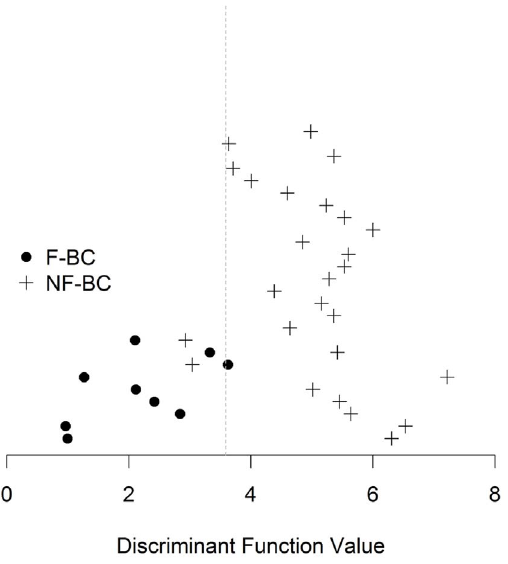
Figure 1. Cross-validation analysis graphic. Representative cross- validation analysis graphic of 35 patients from the F-BC and NF-BC groups. Black spots indicate F-BC samples while plus signs indicate NF- BC samples. The line represents the limit discriminant function between groups. F-BC, familial breast cancer; NF-BC, non-familial breast cancer.